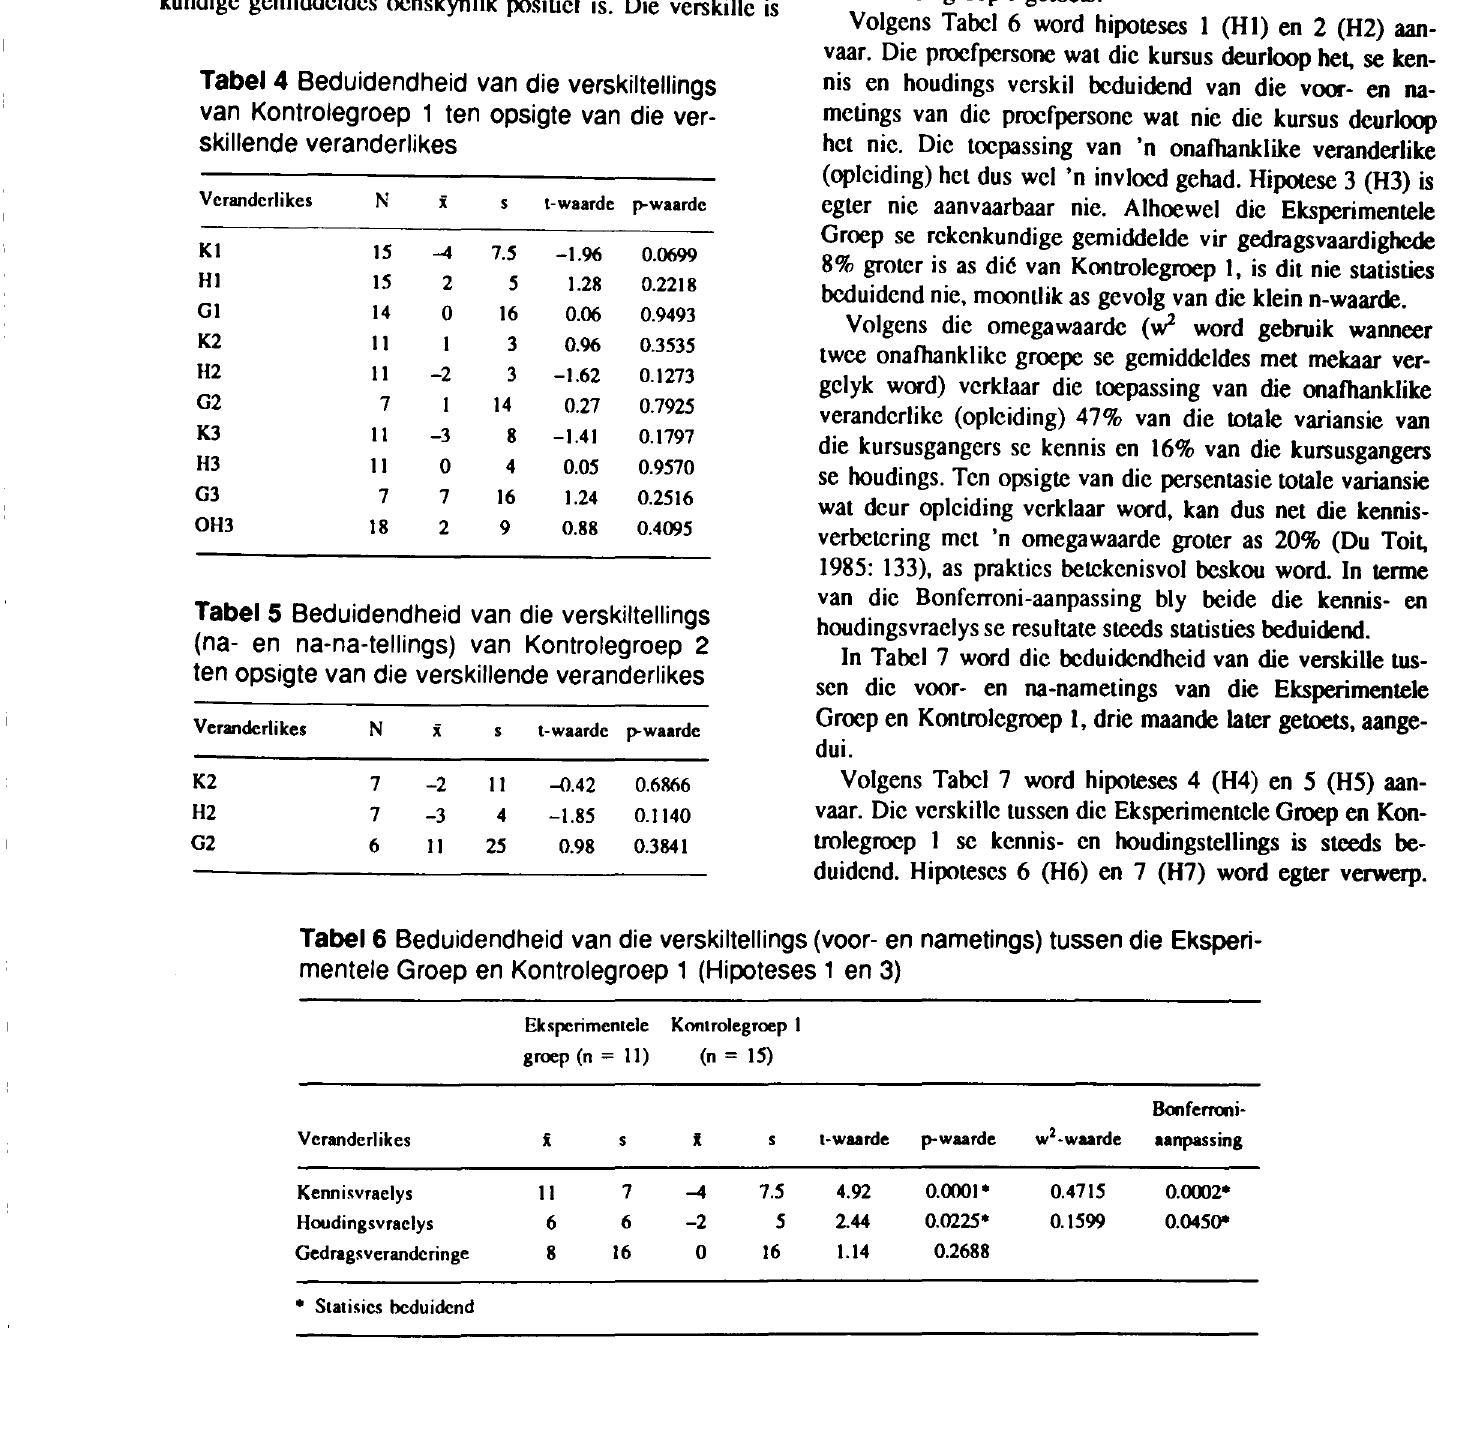
In Tabcl 2 word aangctoon dat daar geen statistics